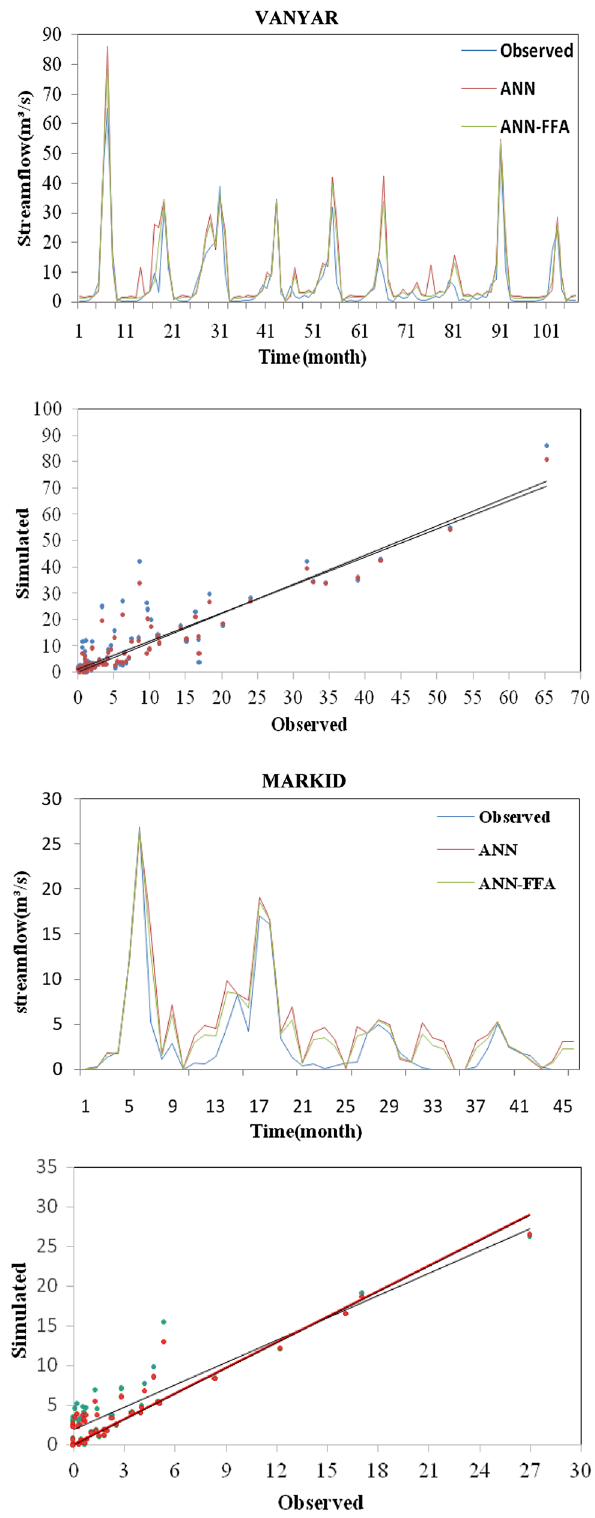
Fig. 5 Comparison between time series plots of simulated and observed values; and scatter plot of observed and simulated